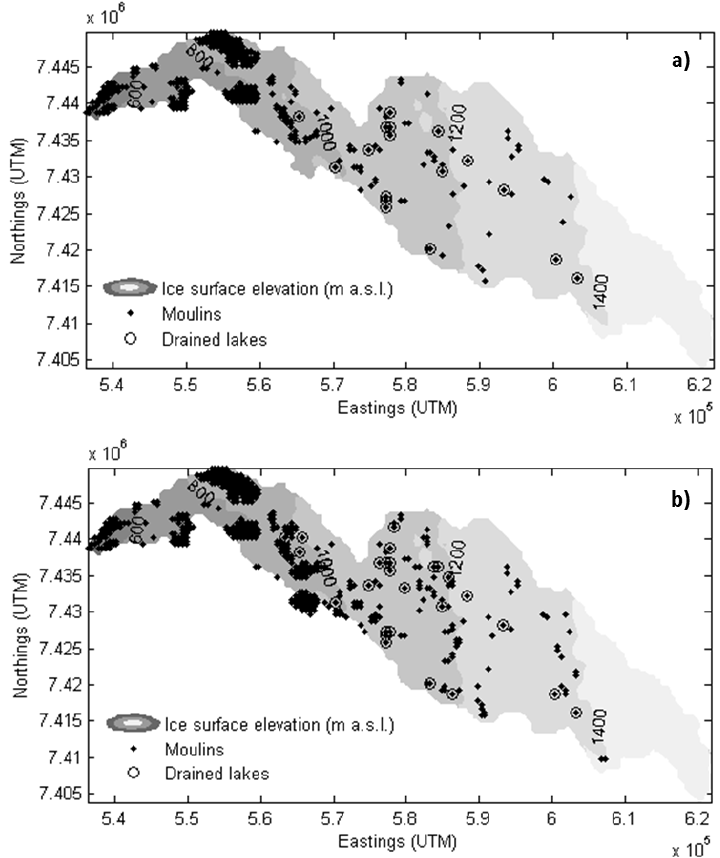
Figure 4. Spatial distribution of moulins and lake drainages for (a) 2009 and (b)